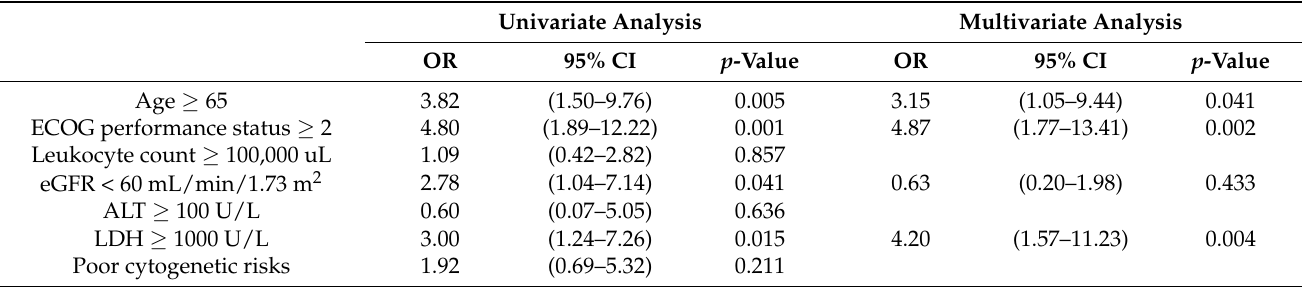
Table 2. Risk factors associated with early